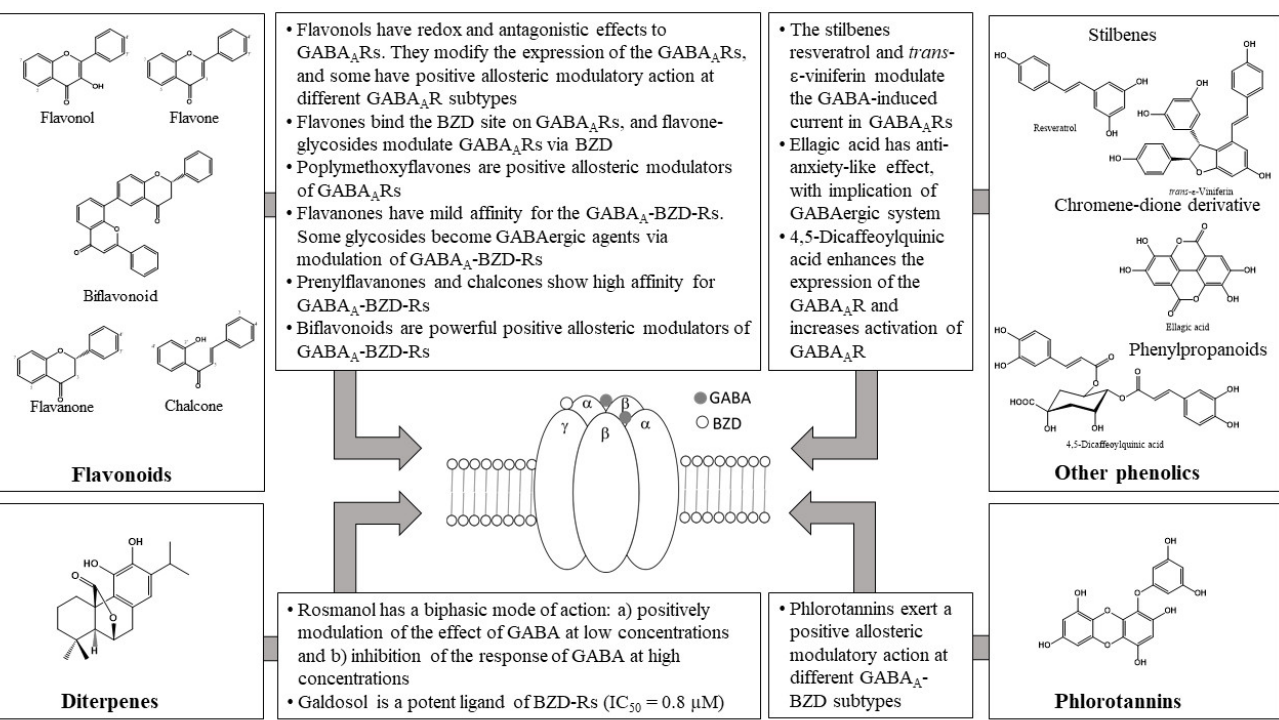
Figure 5. Chemical structures of active phenol-diterpenes on GABA A receptor.